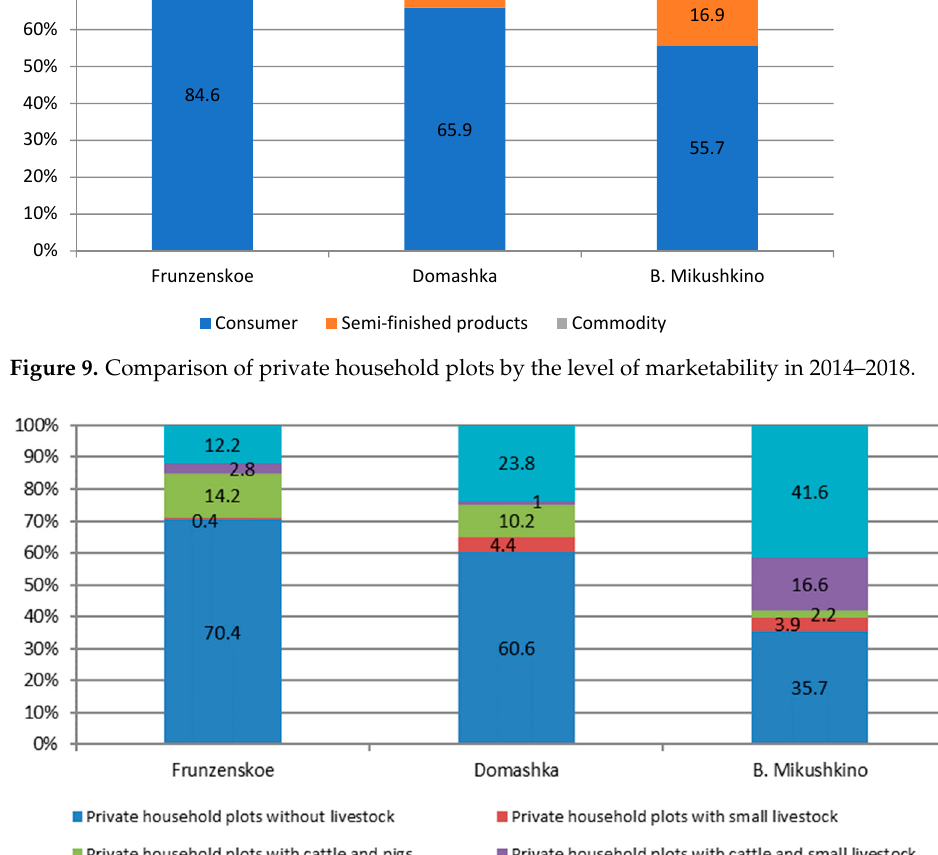
Figure 10. Comparison of private household plots by livestock.